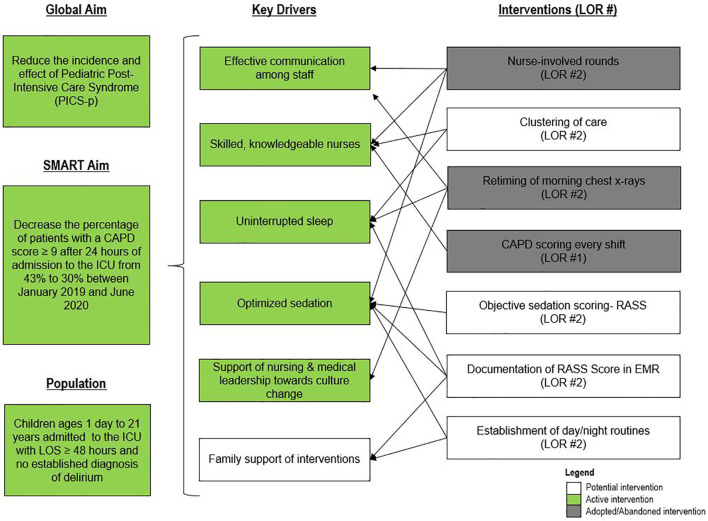
Key driver diagram targeting delirium. CAPD, Cornell Assessment of Pediatric Delirium; ICU, intensive care unit; LOR, level of reliability; LOS, length of stay; RASS, Richmond Agitation Sedation Scale.